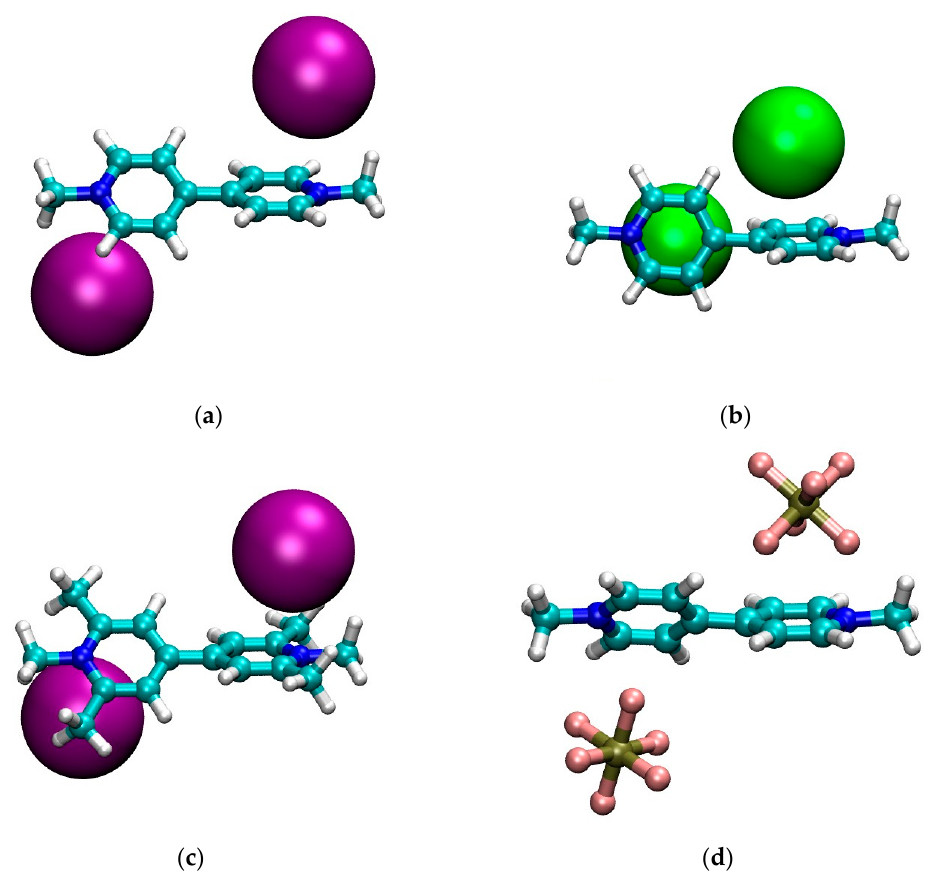
Figure 1. Optimized geometries in CH 2 Cl 2 of: ( a ) MVI 2 ; ( b ) MVBr 2 ; ( c ) MTMVI 2 ; ( d ) MV(PF 6 ) 2 . Graphics produced with VMD [35].